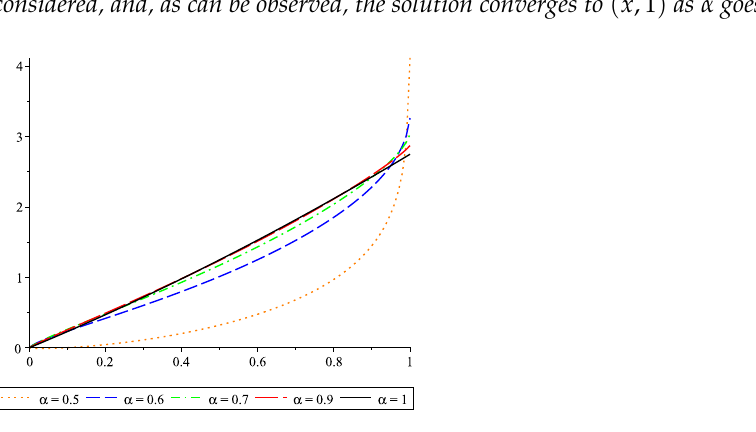
Figure 1. Numerical solutions for Example